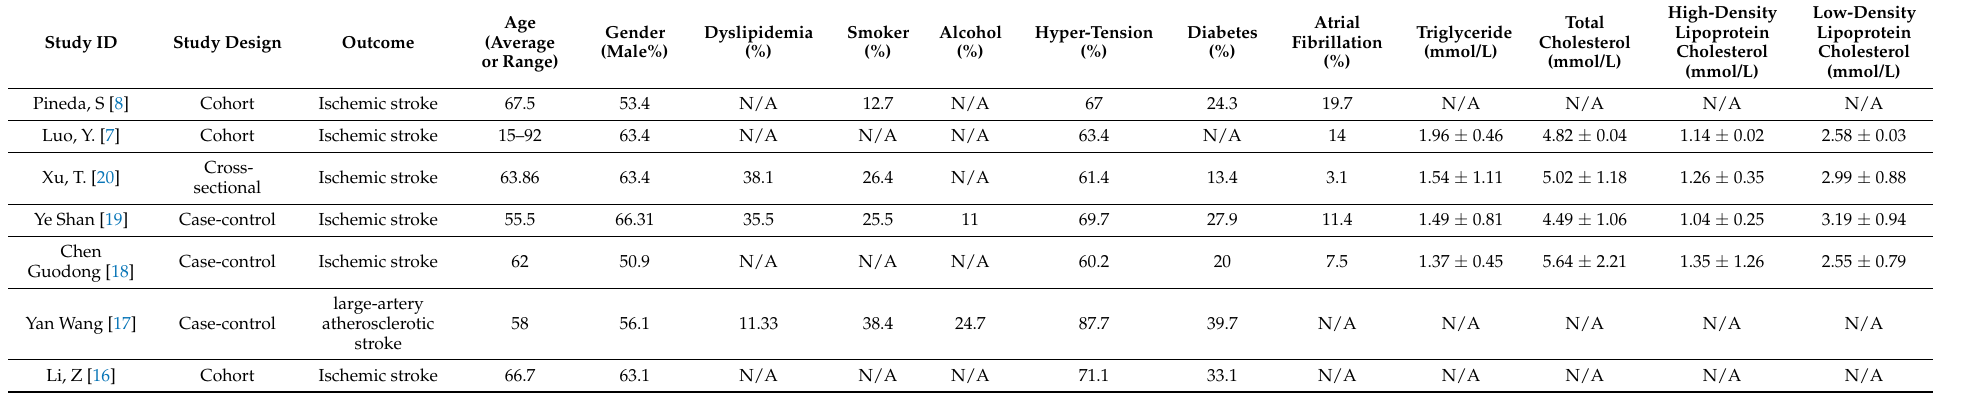
Table 1. The basic characteristics of the subjects in the included